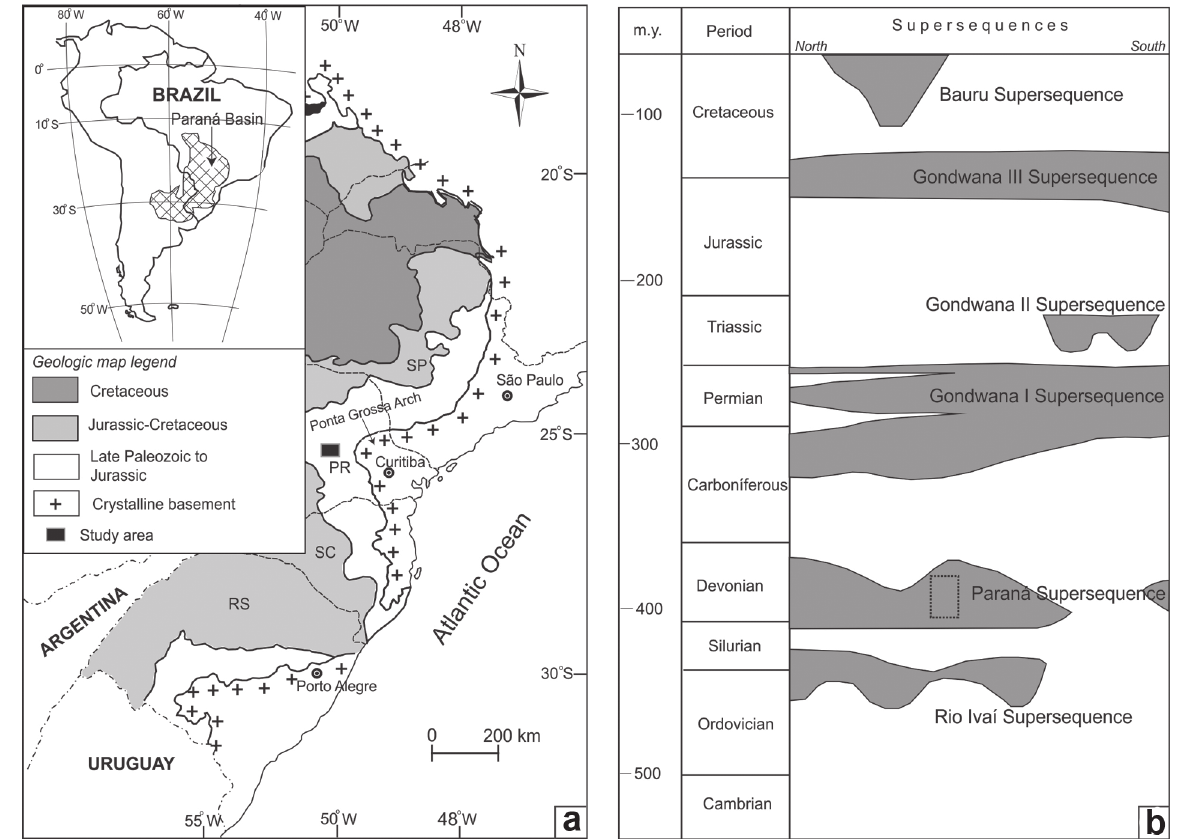
Figure 2 - a . Location map of the study area in the Paraná Basin record. b . Stratigraphic position of the interval analyzed herein (= rectangle) within the Paraná Supersequence (modified of the Milani and Ramos 1998, Milani et al.